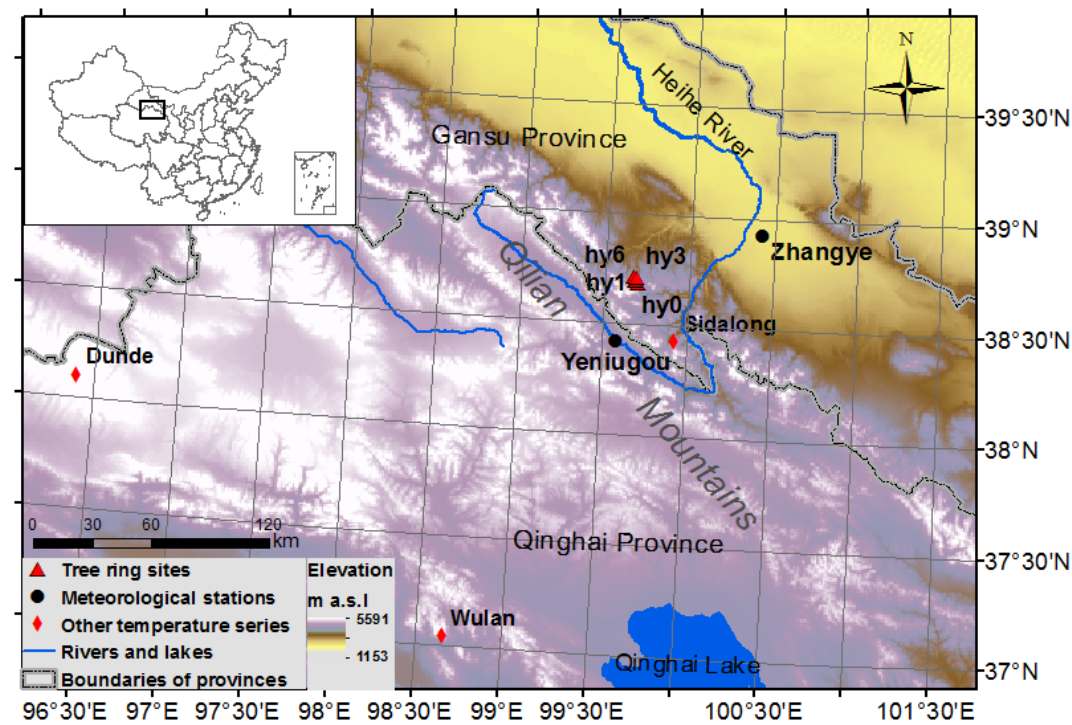
Figure 1. Locations of tree-ring sampling sites, meteorological stations, and other temperature-related series in the Qilian Mountains (Sida- long: Liu et al., 2007; Wulan: Zhu et al., 2008; Dunde: Thompson et al.,